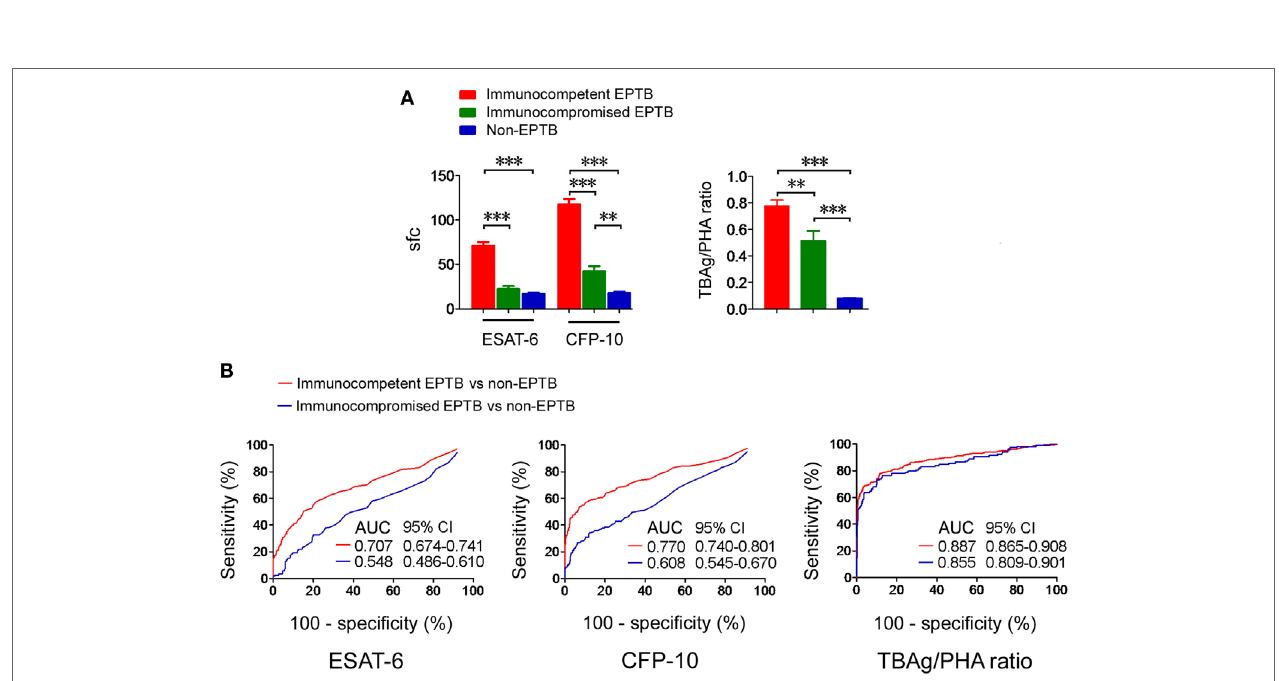
FigUre 4 | T-SPOT results and the TBAg/PHA ratio in patients with different immune status. (a) Histograms showing ESAT-6 sfc, CFP-10 sfc, and the TBAg/PHA ratio in immunocompetent EPTB patients ( n = 528), immunocompromised EPTB patients ( n = 119), and non-EPTB controls ( n = 367) with positive T-SPOT results. Data are shown as the mean ± SEM (** p < 0.01 and *** p < 0.001). (B) Receiver operating characteristic analysis was performed for ESAT-6 sfc, CFP-10 sfc, and the TBAg/PHA ratio in distinguishing between immunocompetent EPTB and non-EPTB or between immunocompromised EPTB and non-EPTB. Abbreviations: EPTB, extrapulmonary tuberculosis; ESAT-6, early secreted antigenic target 6; CFP-10, culture filtrate protein 10; AUC, area under the curve; CI, confidence intervals; TBAg, TB-specific antigen; PHA, phytohemagglutinin; sfc, spot-forming